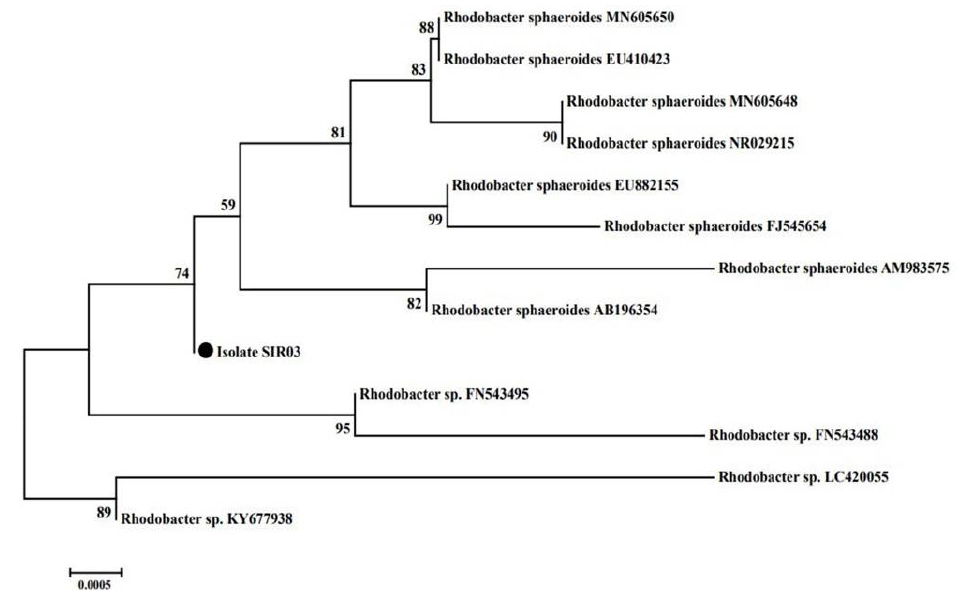
Figure 3. Phylogenetic tree of ALT1, which was constructed using 16S rRNA sequences by neighbor- joining and maximum likelihood methods.